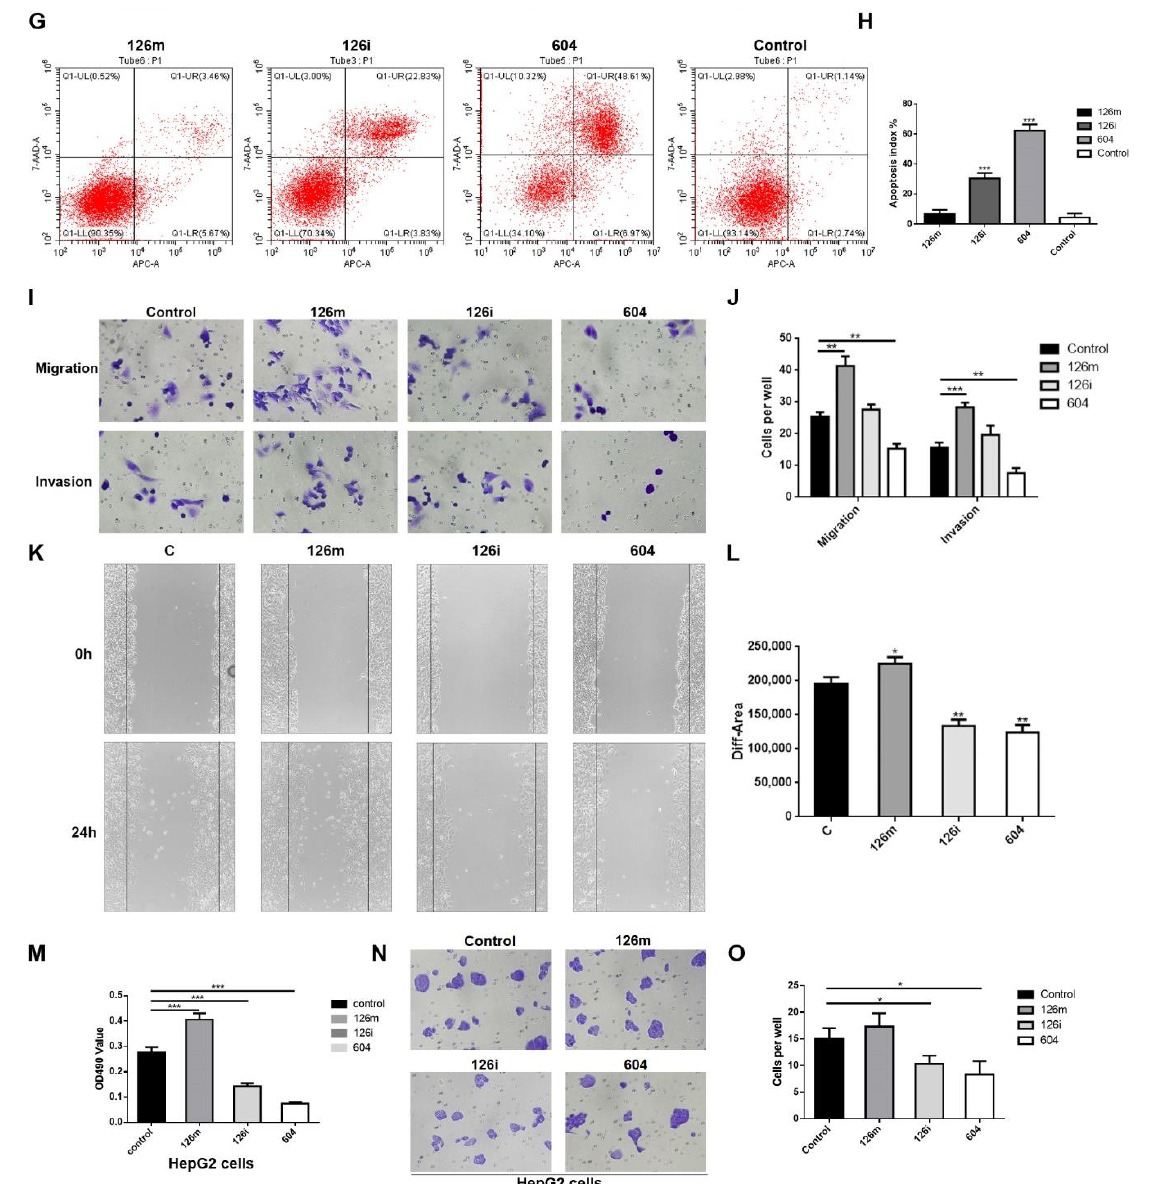
Figure 3. MiR-126-5p can significantly promote the proliferation, migration, and invasion of HCCLM3 cells, and inhibit apoptosis. ( A ) Selection of the most effective siRNA of TDO2. ( B ) Effect of miR-126-5p on HCCLM3 cells growth deter-